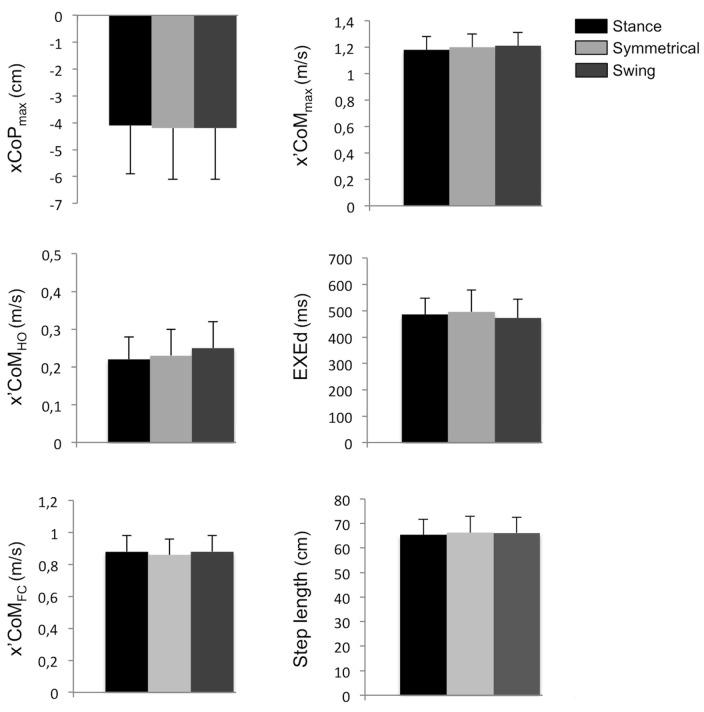
Mean of parameters related to the forward progression under the Stance, Symmetrical and Swing conditions. xCoPmax: maximal backward shift of the CoP during APA. x’CoMHO: anteroposterior velocity of the CoM at heel-off. x’CoMFC: anteroposterior CoM velocity at foot-contact. x’CoMmax: peak of the anteroposterior CoM velocity at the end of the first step. EXEd: duration of step execution. Negative values indicate a displacement or velocity directed backwards.